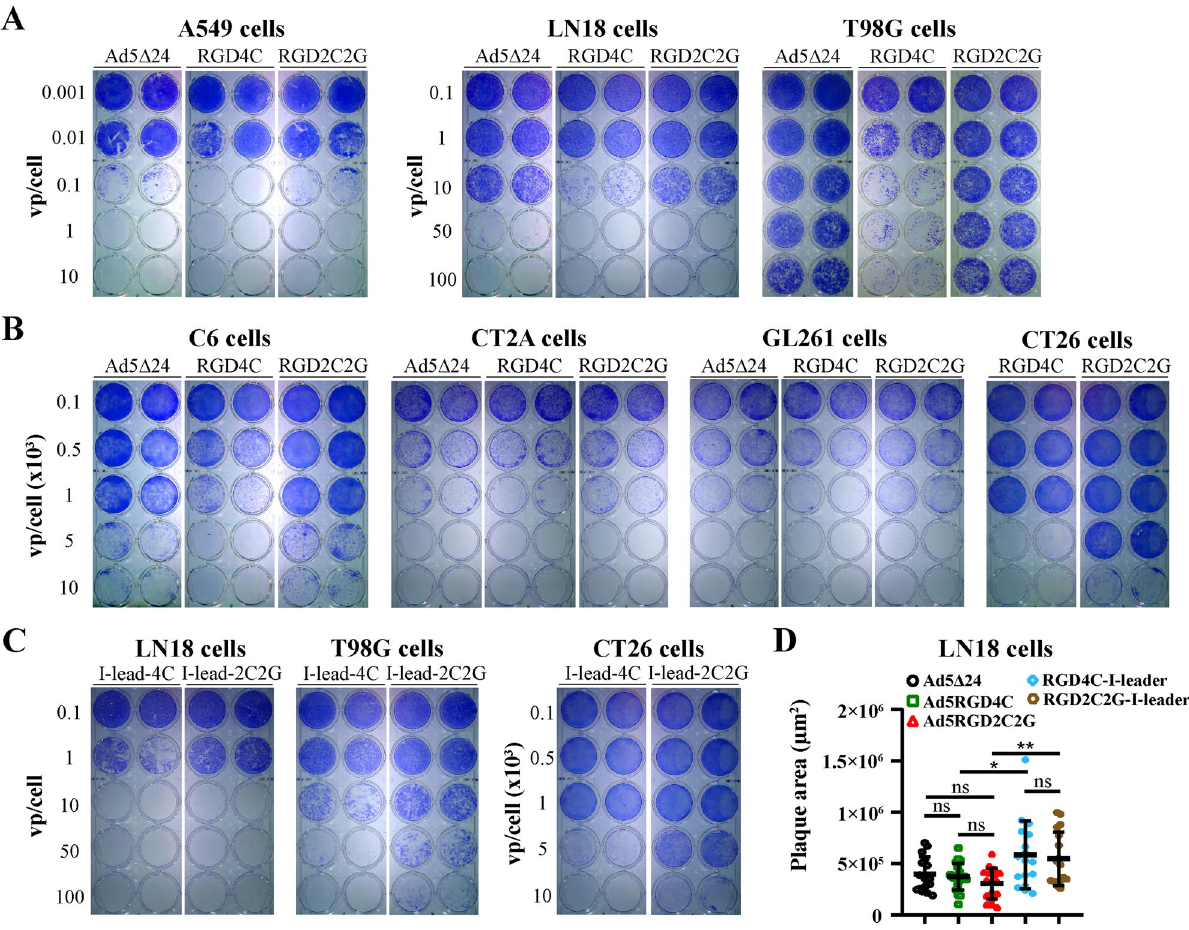
Figure 4. A cysteine-to-glycine substitution after the RGD motif within the RGD-4C peptide (RGD-2C2G) in the HI loop of the fiber knob domain reduced the cytotoxic efficacy in human and rodent cell lines. ( A ) Crystal violet staining of rAd infected human lung adenocarcinoma A549 and glioma LN18 and T98G cells. Cells (2.5 × 10 4 per well, 24-well plate) were infected in suspension with rAds in a serial dilution. Eight days after infection, cells were stained with crystal violet to assess comparative cytotoxic effect of Ad5-delta-24, Ad5- delta-24-RGD4C, and Ad5-delta-24-RGD2C2G. Representative pictures of two independent experiments in duplicate with similar results are shown. ( B ) Crystal violet staining of rAd infected rat glioma C6 cells, murine glioma CT2A and GL261 cells, and murine colon carcinoma CT26 cells. Cells (2.5 × 10 4 per well, 24-well plate) were infected in suspension with rAds in a serial dilution. Five days after infection, cells were stained with crystal violet to assess comparative cytotoxic effect of Ad5-delta-24-RGD4C and Ad5-delta-24-RGD2C2G. Representative pictures of two independent experiments in duplicate with similar results are shown. ( C ) Comparative cytotoxic effect of Ad5-delta-24-RGD4C-I-leader (Q125Stop) and Ad5-delta-24-RGD2C2G-I- leader (Q125Stop) in human and murine cells. Cells were treated and analyzed as in ( A , B ). ( D ) Comparison of the plaque areas of the indicated rAds in LN18 cells at day 10 post-infection (1% agarose overlay). Data are presented as mean ± SD, **p < 0.01, *p < 0.05 by unpaired two-tailed t-test with Welch’s correction. The sample sizes are indicated in the figure (n =